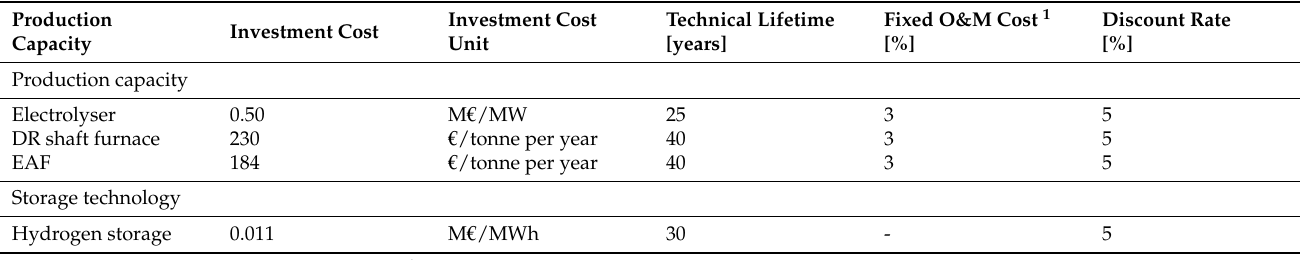
Table A1. Assumed costs and technical data for steel production capacities and hydrogen storage in the H-DR production process.